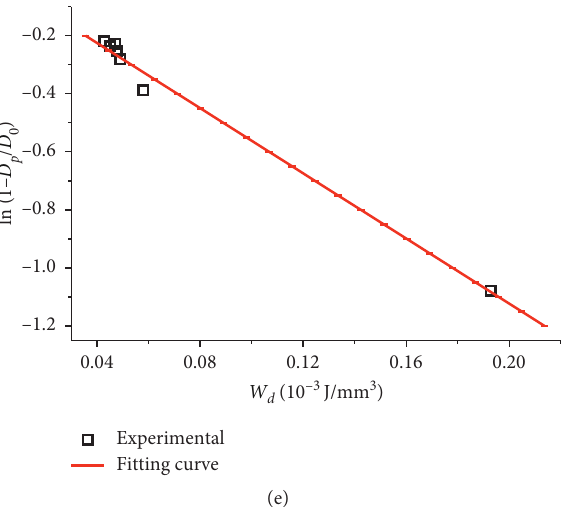
Figure 13: Electrical displacement versus dissipated energy. (a) σ σ 0 � 65, d σ /d t � 0.5. (e) σ 0 � 65, d σ /d t � 1.5 (in the units of MPa and MPa/s,